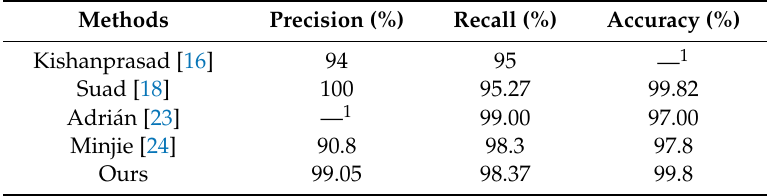
Table 2. Performance of our system compared with existing methods using the same dataset.